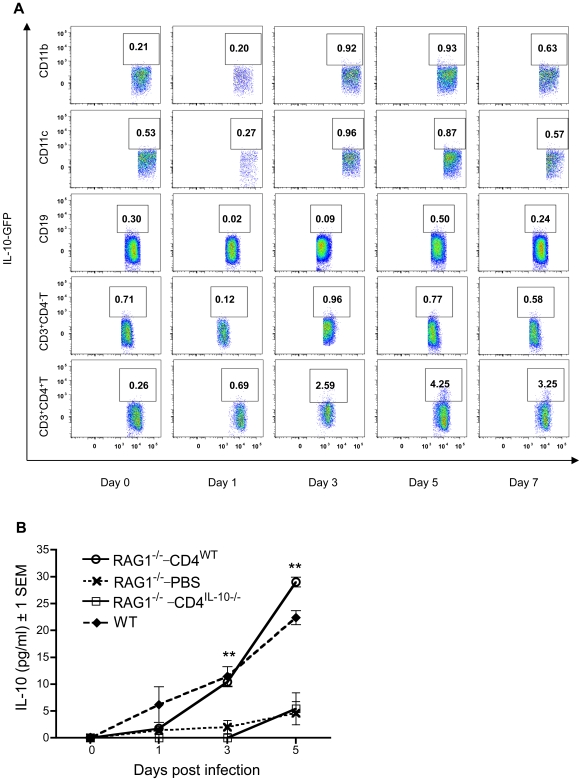
CD4+ T cells produce copious amounts of IL-10 in vivo during WNV infection.GFP gene knock-in tiger and wild-type (WT, C57BL/6) mice were i.p. challenged with WNV (LD50). Splenocytes isolated from WNV-infected tiger mice at selected time points p.i. were stained for surface markers (day 0, uninfected splenocytes). GFP was used as a surrogate for IL-10 expression, and analyzed by flow cytometry. (A), Percentages of GFP positive cells are shown within CD11b+ (macrophages), CD11c+ (dendritic cells), CD19+ (B cells), non-CD4+ (CD3+CD4−) T cells or CD4+ (CD3+CD4+) T cells populations. Dot-plot figures are representative of at least two independent experiments (n≥2 for each experiment). (B), RAG1−/− mice were reconstituted with CD4+ T cells from naïve WT or IL-10−/− mice (1×107 cells/mouse) or with PBS as control one day prior to WNV challenge (LD50, i.p.). Mice were bled at selected time points and IL-10 production was measured in plasma by ELISA (**p<0.01, RAG1−/− mice reconstituted with CD4+ T cells from WT mice were compared to control mice, n≥3/group).